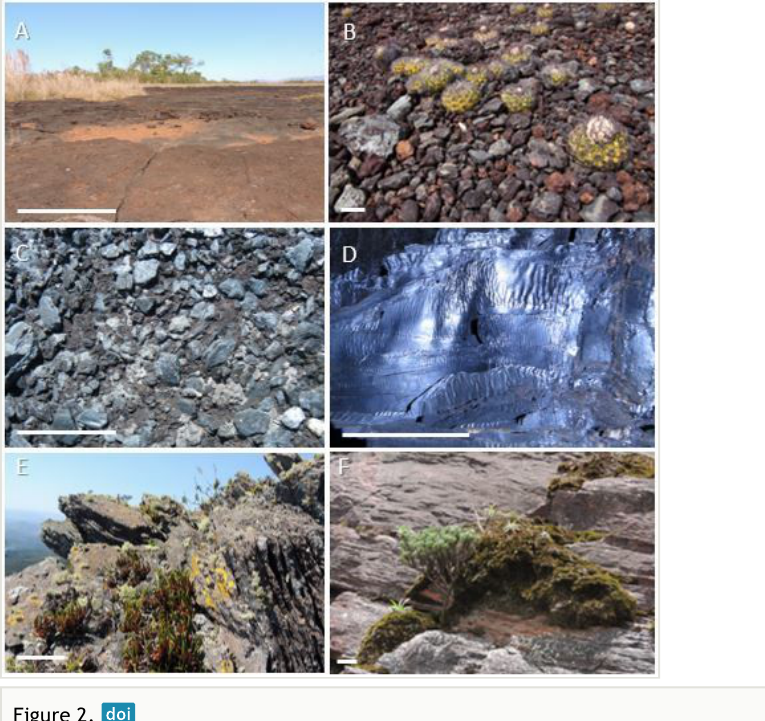
Heterogeneity of outcrops in ironstone ranges. A-C . Canga types (iron duricrusts); D . Specular hematite; E-F . Banded Iron Formations (BIF). The white bar represents 10